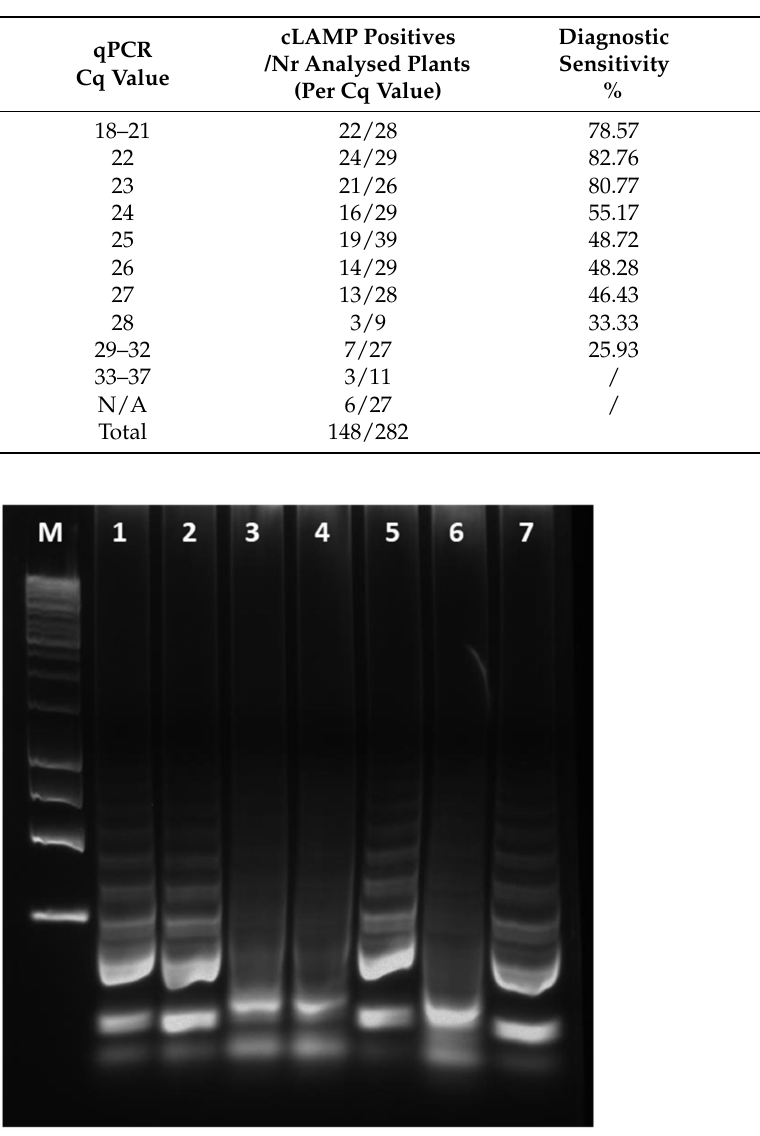
Table 1. Comparative performance of cLAMP vs. qPCR assay for the detection of Xfp in olive alkaline crude extracts. Positive samples obtained by cLAMP are indicated for each group of Cq values obtained from qPCR. Percentage of diagnostic sensitivity and specificity generated by cLAMP assay are reported.